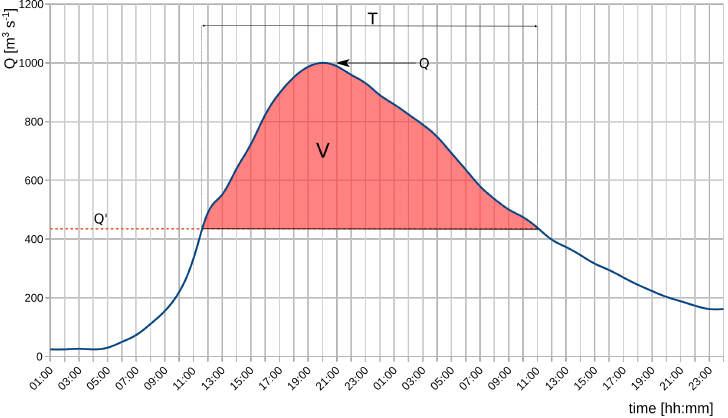
Figure 1. Scheme of a flood hydrograph with the main hydraulic parameters.